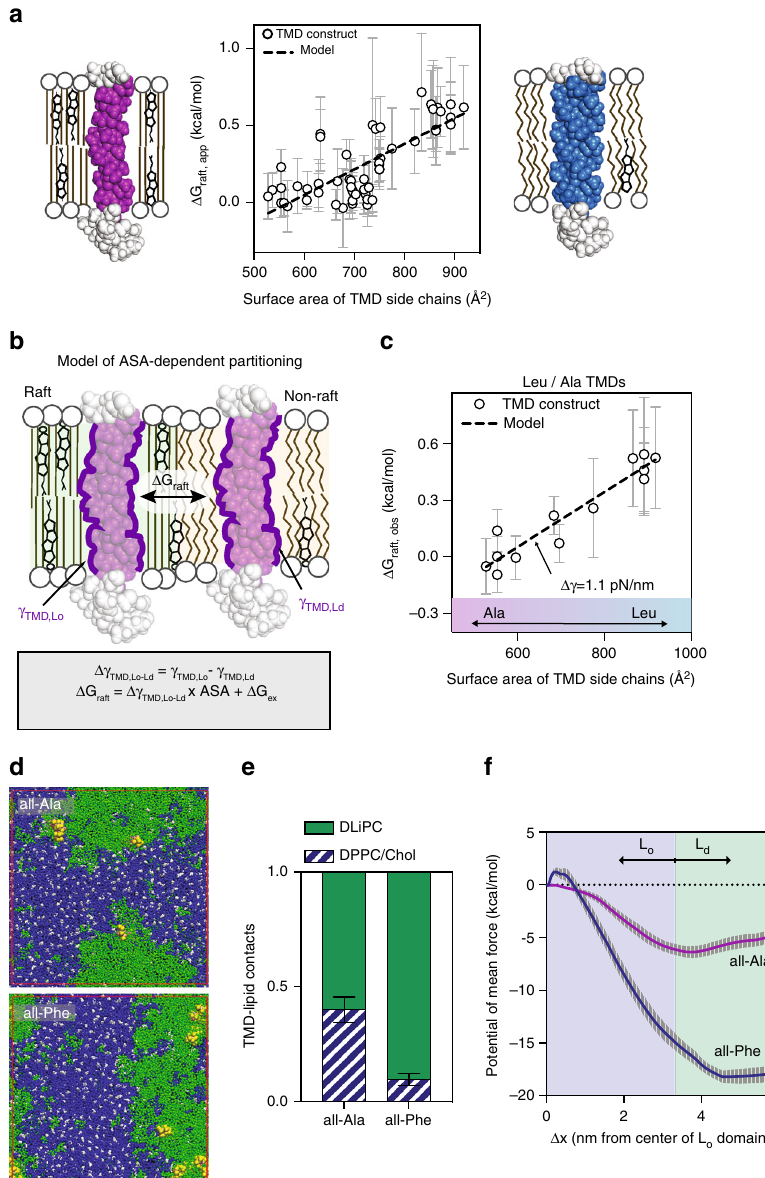
Fig. 2 TMD surface area determines raft partitioning. a For 56 TMD constructs, computed side chain surface area correlates strongly with raft af fi nity ( r = 0.74, p < 0.001), with TMDs with smaller areas preferentially partitioning to the raft phase. b Schematic model for accessible surface area (ASA)- dependent raft af fi nity based on differential interfacial tension ( Δγ TMD,Lo-Ld ) between a TMD and the membrane matrix in raft versus non-raft phases. c Apparent raft af fi nity Δ G raft,app for 12 constructs whose TMDs are comprised solely of Ala and Leu residues shows a clear dependence on TMD side chain surface area. The dotted line shows the model fi t, which yields a prediction for Δγ TMD,Lo-Ld of 1.1 pN/nm (r = 0.93, p < 0.001). Average ± SD for > 10 vesicles/condition representative of 3 – 5 independent trials. Sequences and partitioning values for all variants are given in Supplementary Table 2. d Endpoint snapshots of CG MD simulations of model TMDs (yellow) with small (all-Ala) and large (all-Phe) surface areas in a phase separated membrane composed of 50% DPPC (blue), 30% DLiPC (green), and 20% cholesterol (white). e Quanti fi cation of contacts between TMDs and lipids reveals that all- Ala interacts more avidly with L o lipids (DPPC+Chol) than L d lipids (DLiPC). f Umbrella sampling calculation of relative free energy (PMF) difference resulting from translating a TMD from the center of the L o domain ( x = 0 nm) to the L d ( x = 6 nm). all-Ala has much higher relative L o af fi nity than